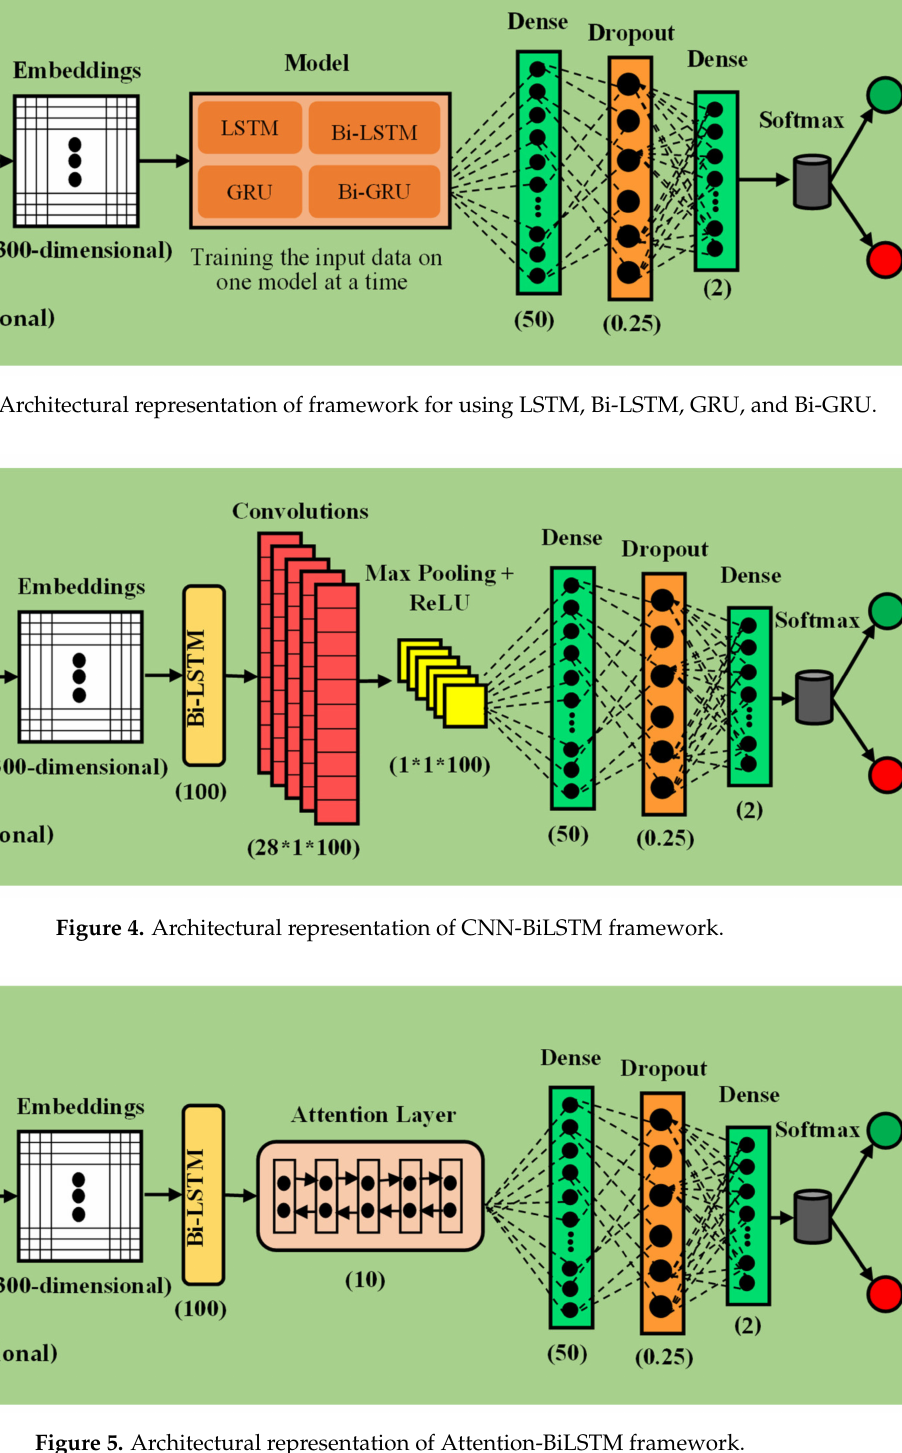
Figure 5. Architectural representation of Attention-BiLSTM framework. CNN: After demonstrating extreme efficiency in image classification tasks, convolu- tional neural networks [51] are widely adopted for text classification. We develop Text-CNN with a single hidden layer and employ it for cyberbullying detection. A convolution